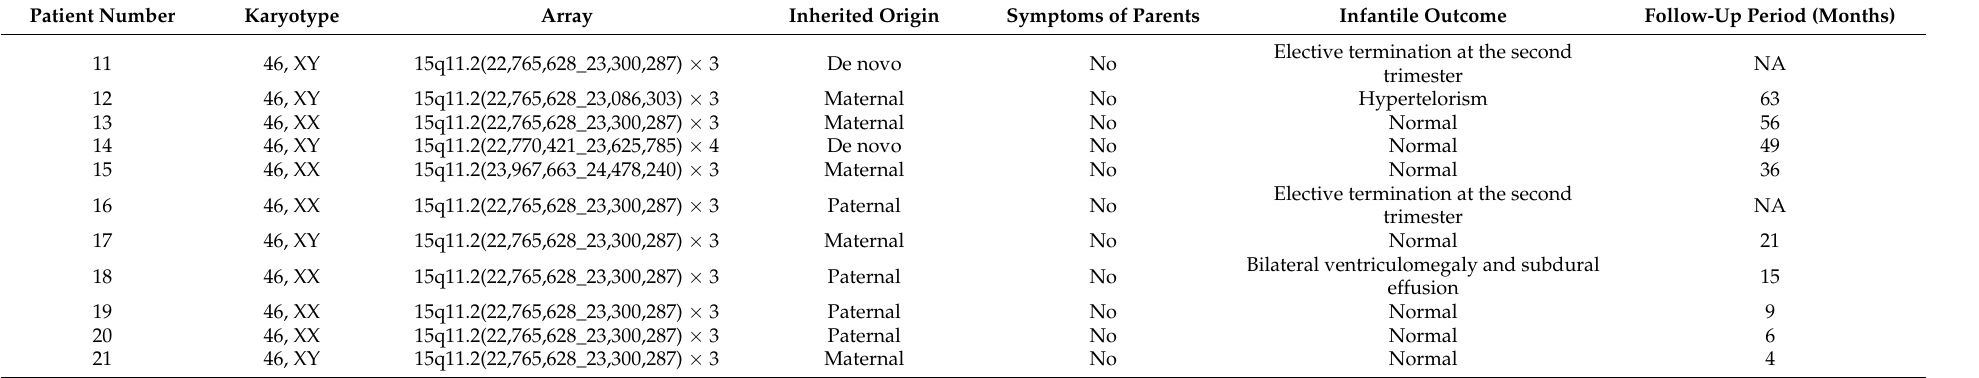
Abbreviations: CHD, congenital heart disease; ASD, atrial septal defect; PDA, patent ductus arteriosus; PS, pulmonary stenosis; PLSVC, persistent left superior vena cava; AS, arterial stenosis; NA, not available. Table 2. Clinical characteristics of children diagnosed with 15q11.2